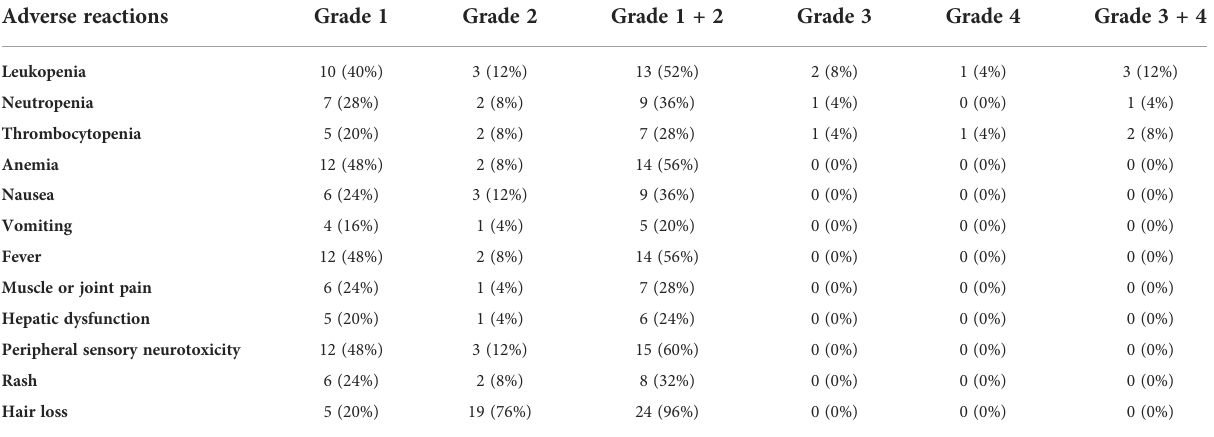
TABLE 3 Adverse reactions during treatment of the 25 patients. Adverse